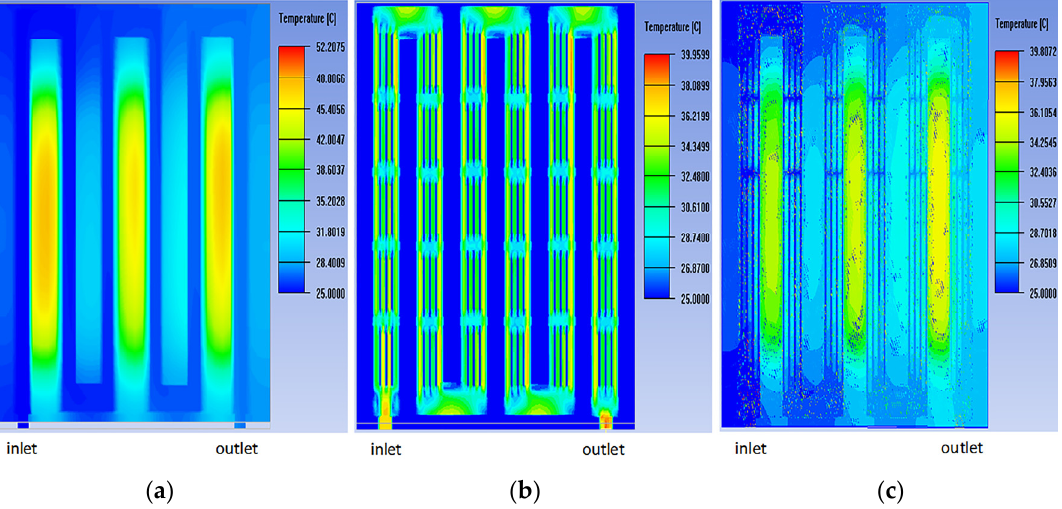
Figure 4. Comparison between the temperature clouds of three types of water ‐ cooled plates. ( a ) No Spoiler Column. ( b ) Rectangular Spoiler Column. ( c ) Elliptical Spoiler Column.